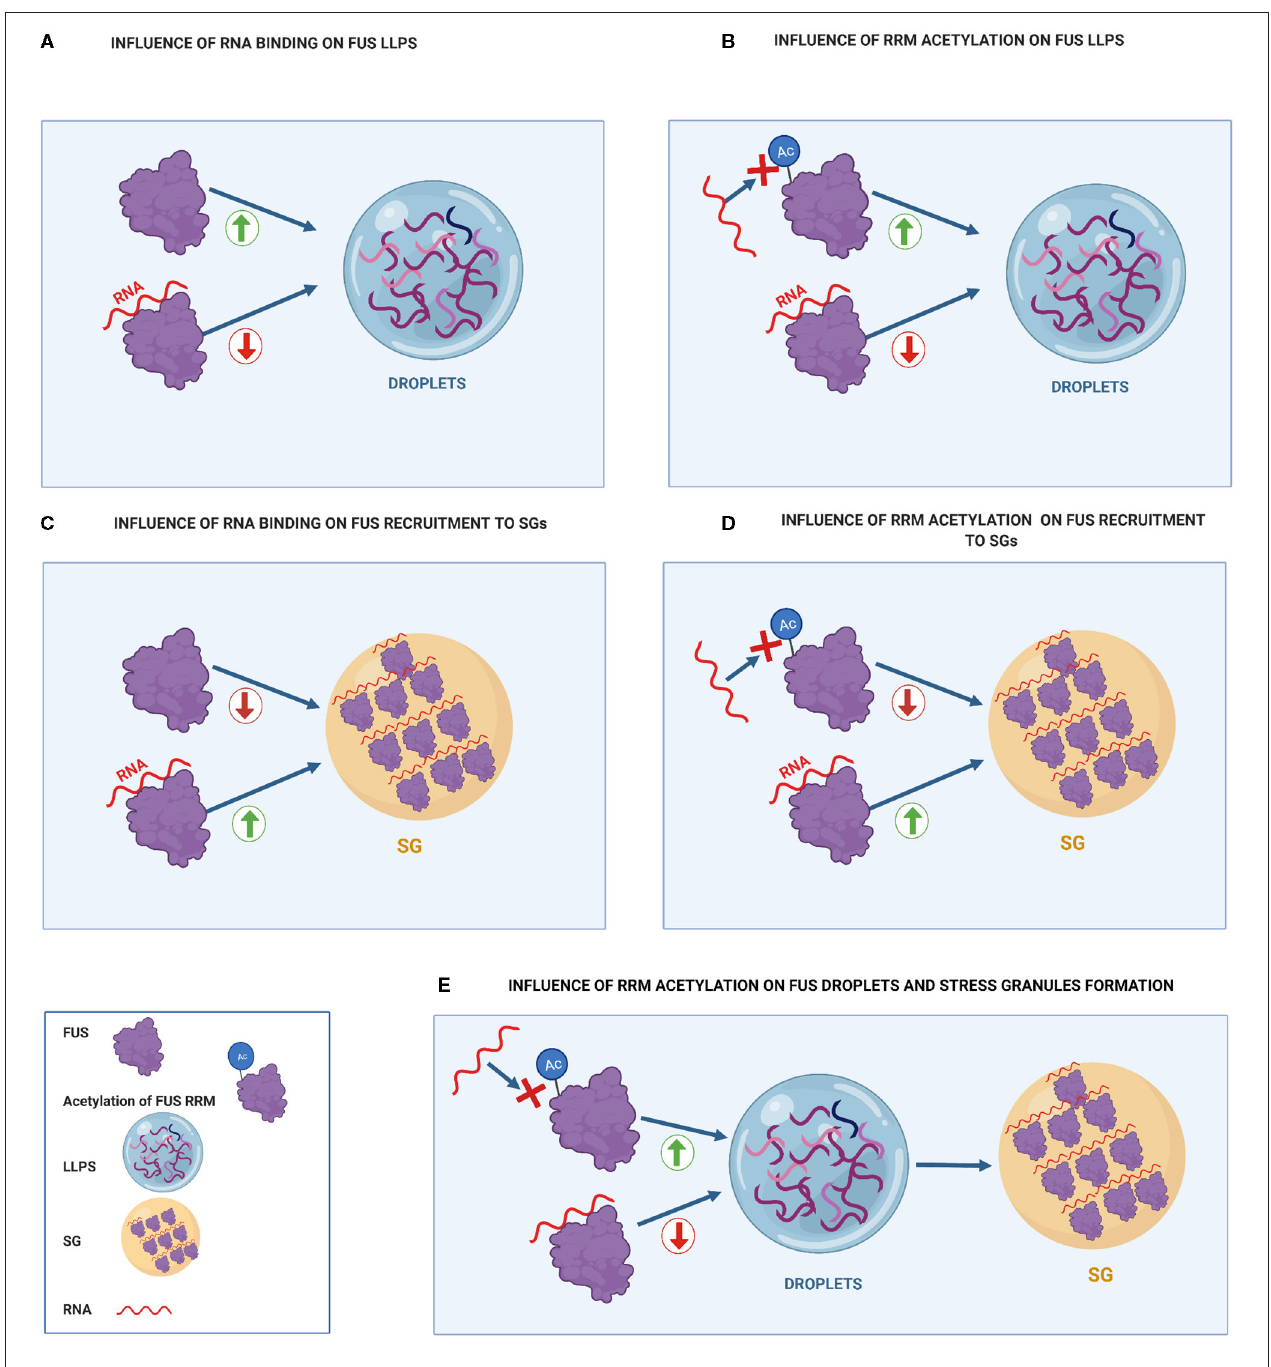
FIGURE 3 | Influence of RNA binding on FUS toxicity compared to the effect of FUS acetylation of RRM residues on FUS toxicity. (A) Influence of RNA binding on FUS LLPS. Binding of FUS to high RNA concentrations prevents it from undergoing LLPS. (B) Influence of RRM acetylation on FUS LLPS. RRM acetylation prevents RNA-RRM interactions, increasing FUS LLPS. (C) Influence of RNA binding on FUS recruitment to SGs. RNA binding increases FUS recruitment to SG. (D) Influence of RRM acetylation on FUS recruitment to SGs. Acetylation of RRM domains prevents FUS from binding to RNA, decreasing FUS recruitment to SGs. (E) Influence of RRM acetylation on FUS droplets and stress granules formation. RRM acetylation promotes droplet formation that can further turn into stress granules. residues) effectively decrease FUS binding to RNA (Liu et al., FUS might be mediated by its RNA binding ability, proposing that FUS forms a FUS–RNA complex before being transported 2013), so we propose that acetylation of these residues could to the cytoplasm. Point mutations in the FUS RRM (K315/K316 reduce FUS binding to RNA and thereby FUS